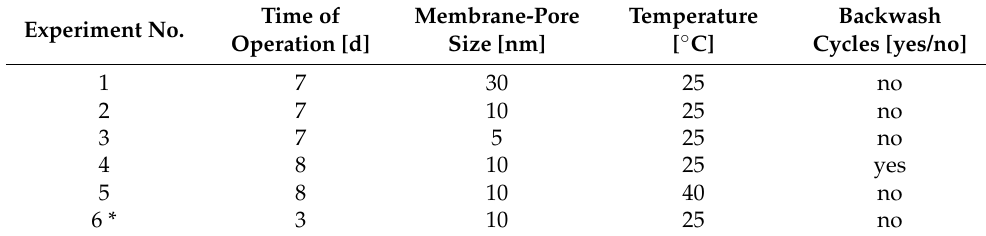
Table 2. Overview of conditions of the experiments used for this study. Experiment